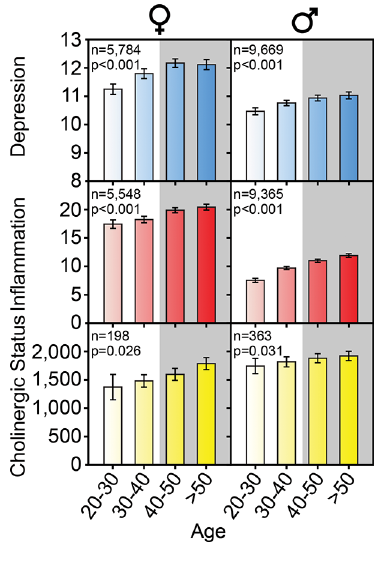
figure 2. Depression, inflammation and cholinergic activities increase with age. Depression scores (sum of 9 items of the “Patient Health Questionnaire” (PHQ)), Inflammation (as reflected by the eryth- rocyte sedimentation rate, ESR, mm/h) and cholinergic enzymatic activities (Cho- linergic status, CS, the total capacity for acetylcholine hydrolysis, nmol substrate hydrolyzed/min per ml (19)) all increase with age in both genders. (Statistics: ANOVA of 4 age groups).